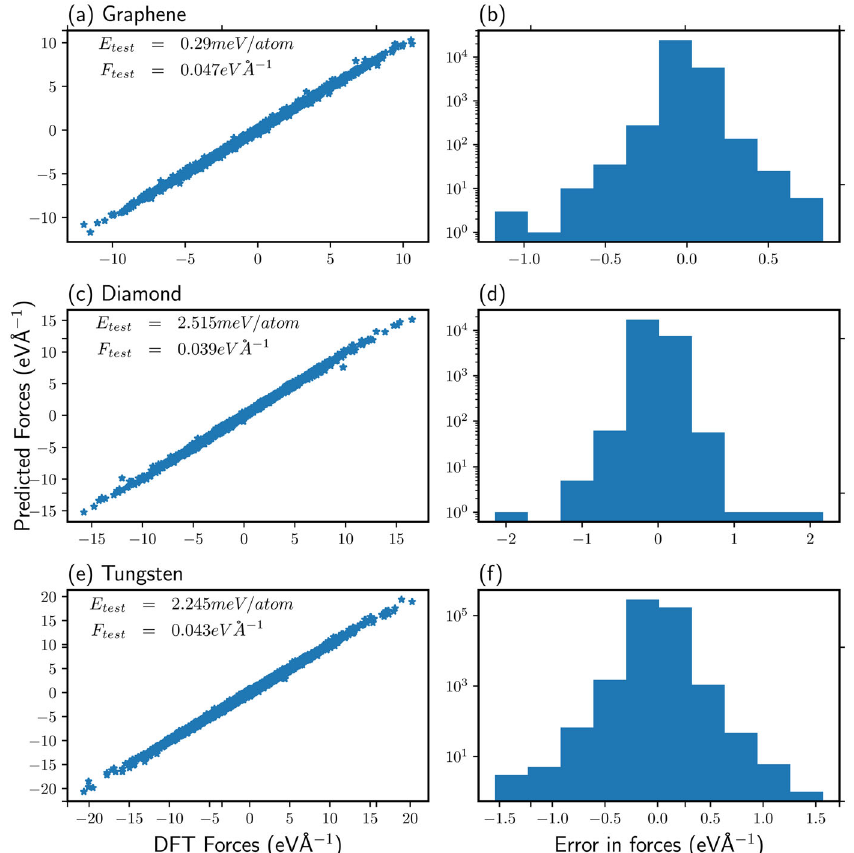
Fig. 1 Prediction accuracy of potential based on random features. Plot of forces predicted through random features versus the DFT computed values. Data was obtained from libatoms.org. Mean absolute error in energy ( E test ) and force ( F test ) prediction is shown in inset for the corresponding test sets ( a , c , e ). Histogram of the force prediction errors is provided for graphene ( b ), diamond ( d ), and tungsten ( f